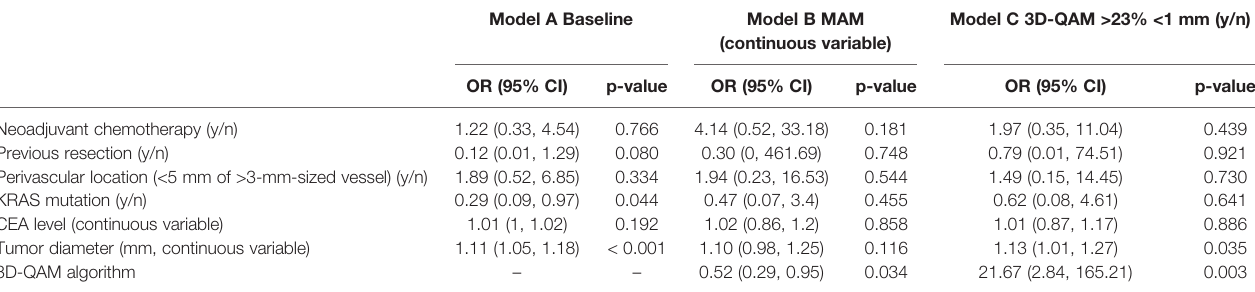
TABLE 3 | Multivariable logistic regression analyses (GEE) of factors potentially predicting ASR per tumor using varying outputs of